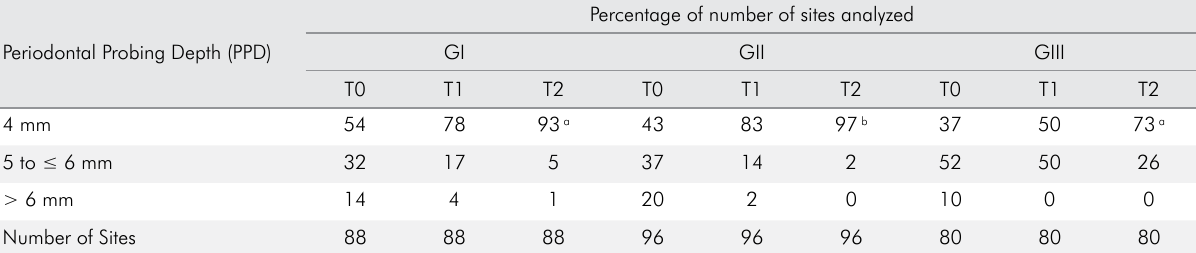
Table 3. Reduction values obtained of periodontal probing depth (PPD) and evaluation by sites and percentage according to PPD categories after treatment with 10% DOX gel and scaling and root planning (SRP) (GI), 10% DOX: β -cyclodextrin gel and SRP (GII) and SRP alone (GIII), at T0 (Baseline), T1 (30 days), T2 (60 days). Periodontal Probing Depth (PPD)